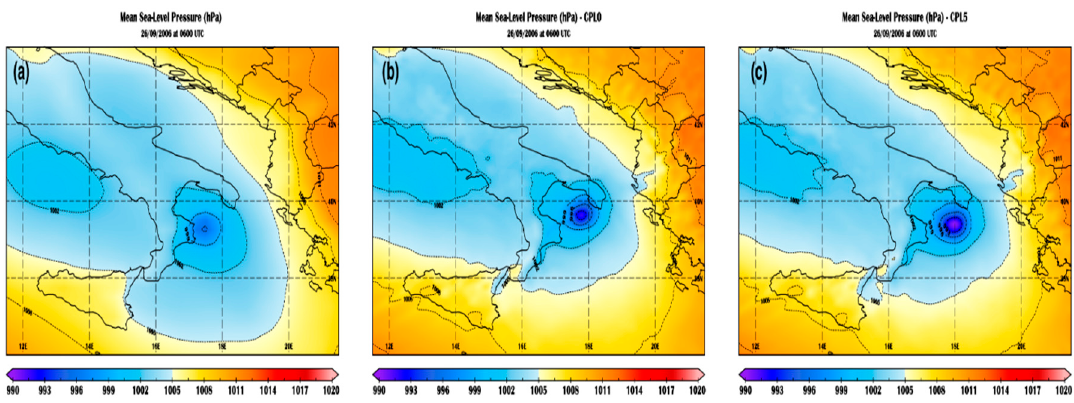
Figure 6. Mean sea-level pressure at 0600 UTC 26 September 2006 of ECMWF analysis ( a ); CPL0 run ( b ); CPL5 run ( c ).